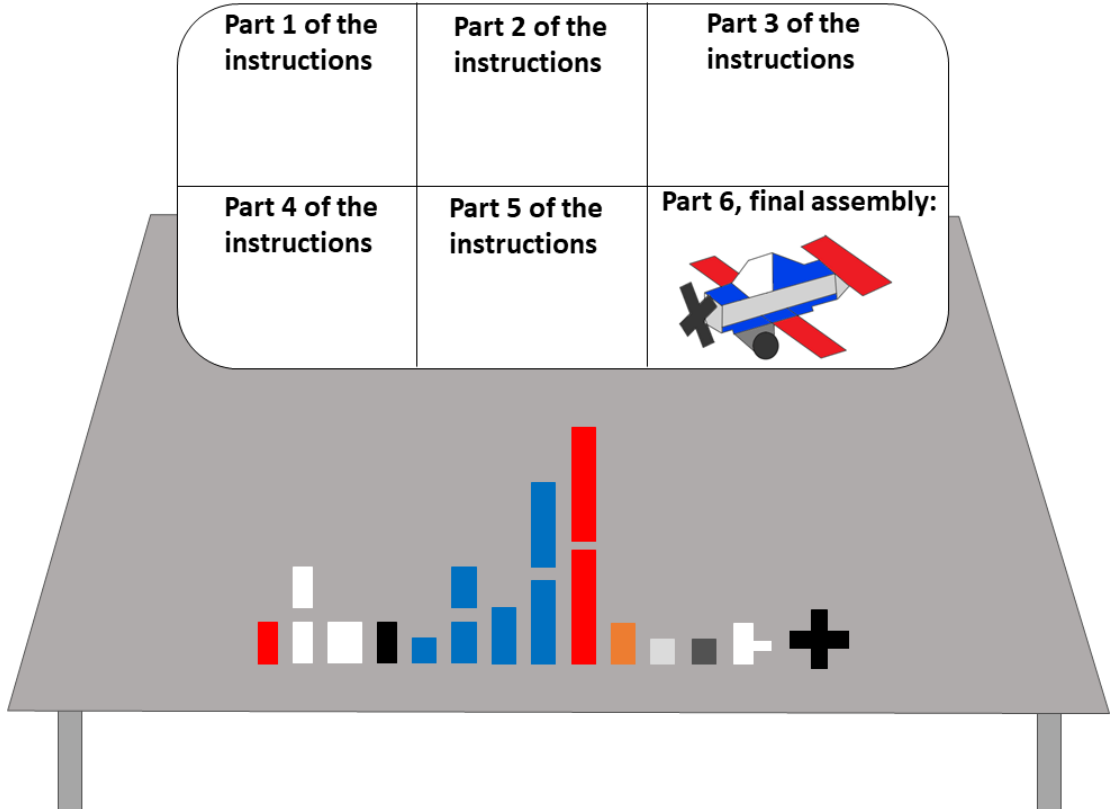
Figure 1. A recreation of the virtual training environment.